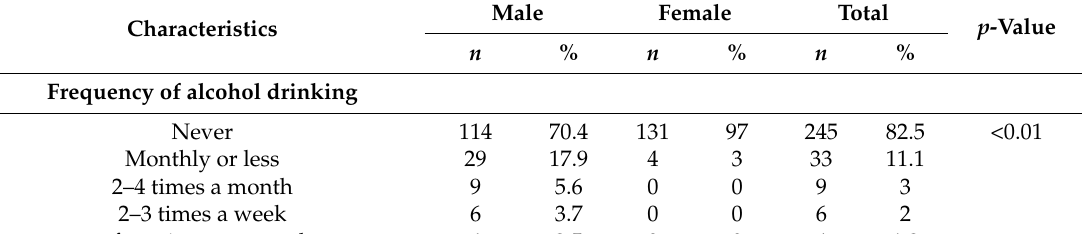
Table 2. Alcohol and tobacco use among CHB patients.